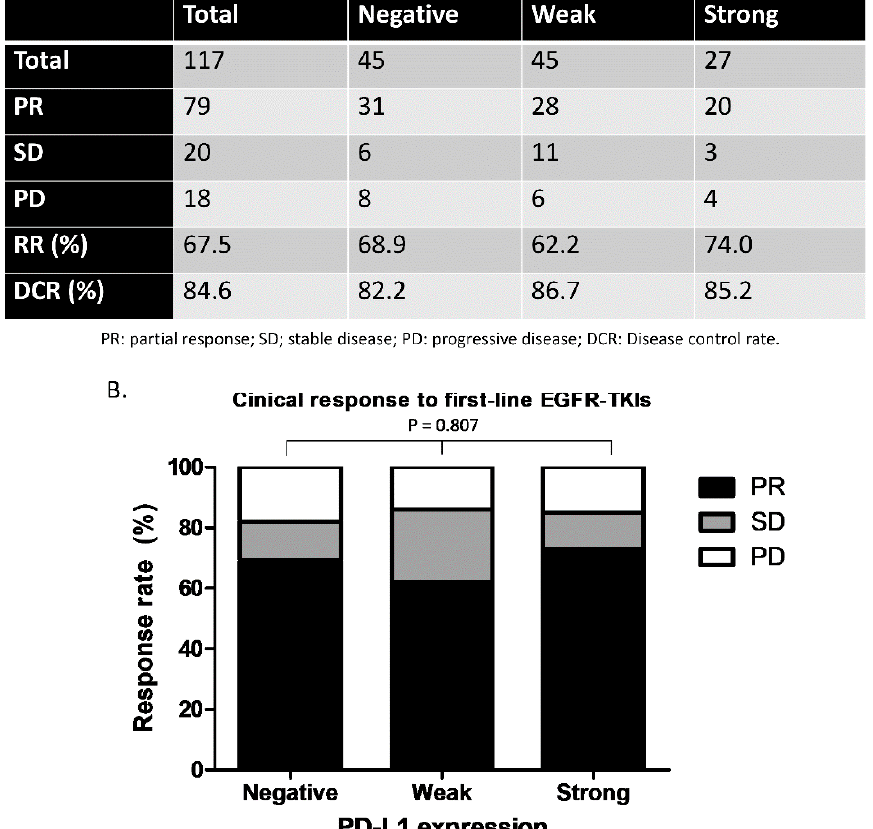
Figure 3. Clinical response to first-line EGFR-TKIs in this study. ( A ) Overall response rate and disease control rate for the three groups of patients. ( B ) Comparison of the response rate between the three groups of patients ( p = 0.807). PR, partial response; SD, stable disease; PD, progressive disease; DCR, disease control rate.